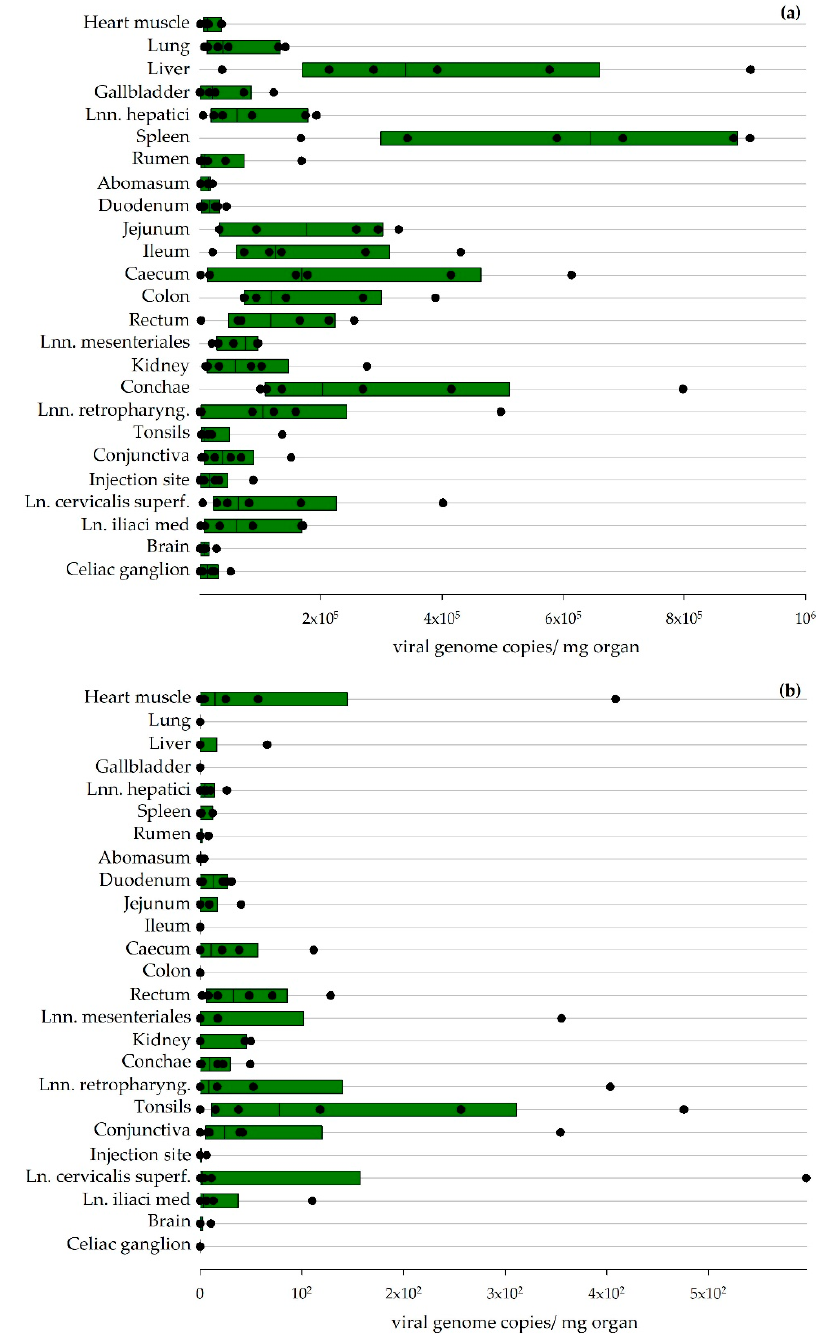
Figure 5. Viral organ loads detected via RT-qPCR in sheep: Results for sheep euthanized 7/8 dpi ( a ) and 27/28 dpi ( b ) are depicted. The boundaries of the boxes indicate the 25th and 75th percentiles, and the line within the box marks the median (calculation performed by